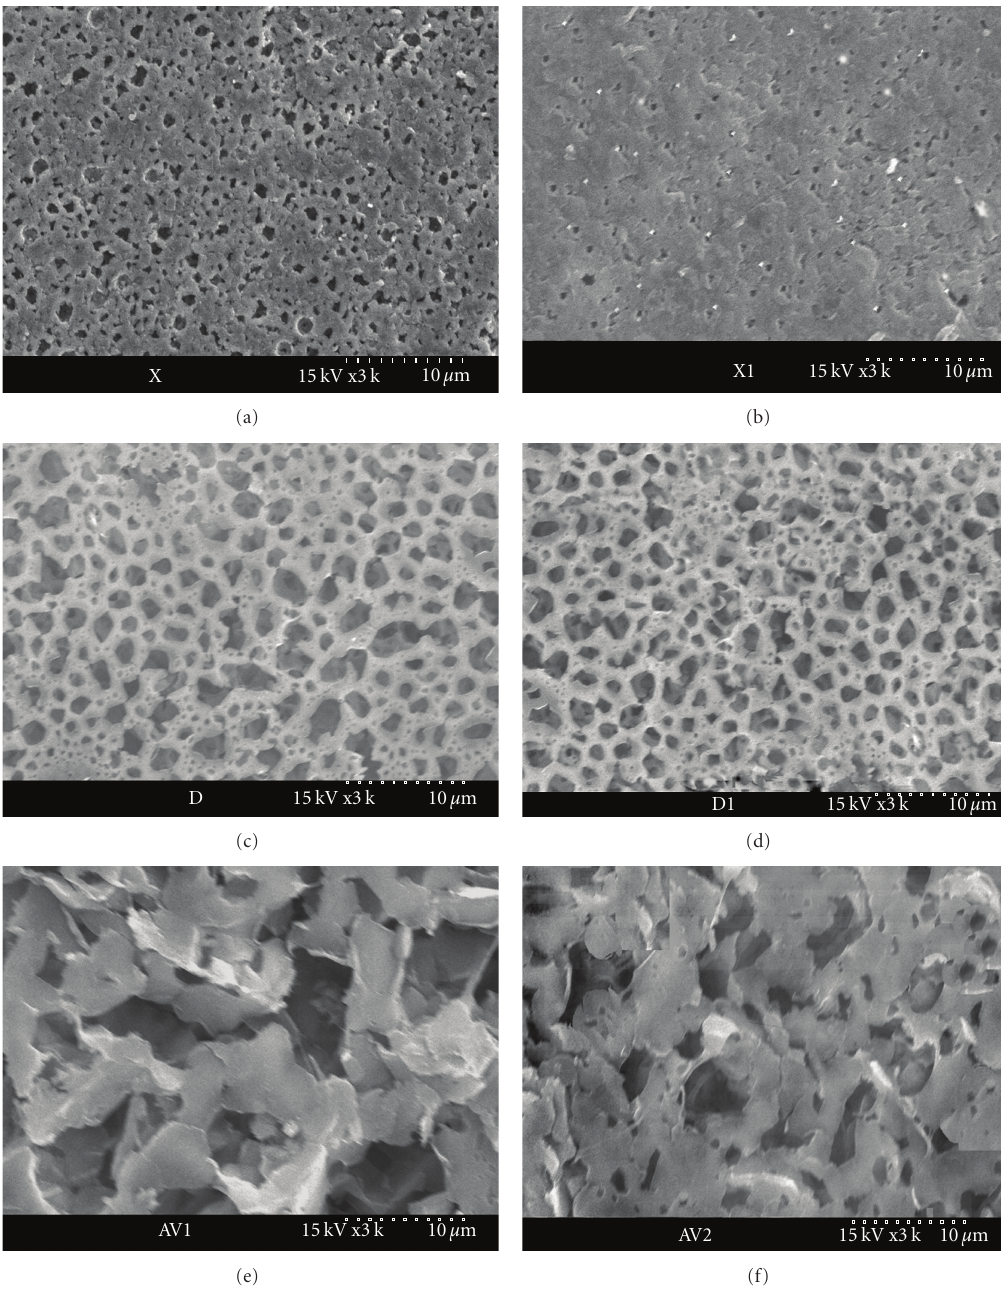
Figure 1: FE-SEM images of PICM with the addition of 8 wt% CeO 2 (a) top surface view (b) bottom surface view; PDCM with the removal of 20wt% PVP from P(VdF-co-HFP)-CeO 2 /removal PVP matrix (c) top surface view (d) bottom surface view; PDCM with the removal of 30wt% PVP from P(VdF-co-HFP)-CeO 2 /removal PVP matrix (e) top surface view (f) bottom surface